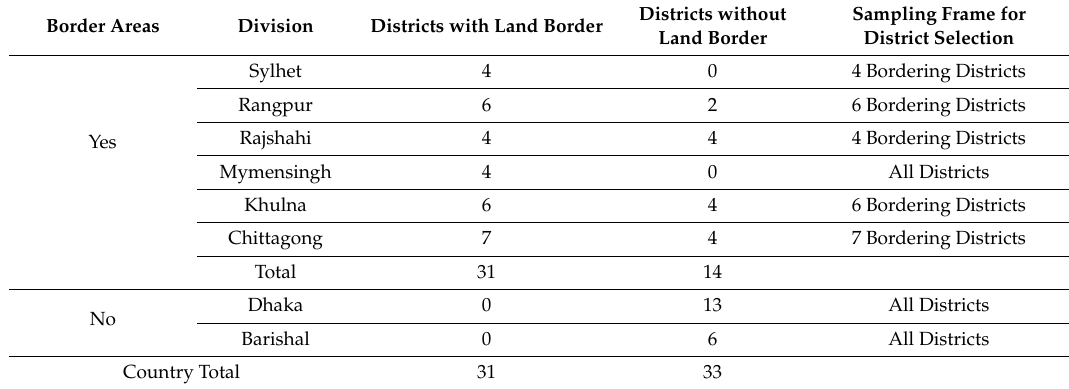
Table 1. Administrative areas with border status and sampling